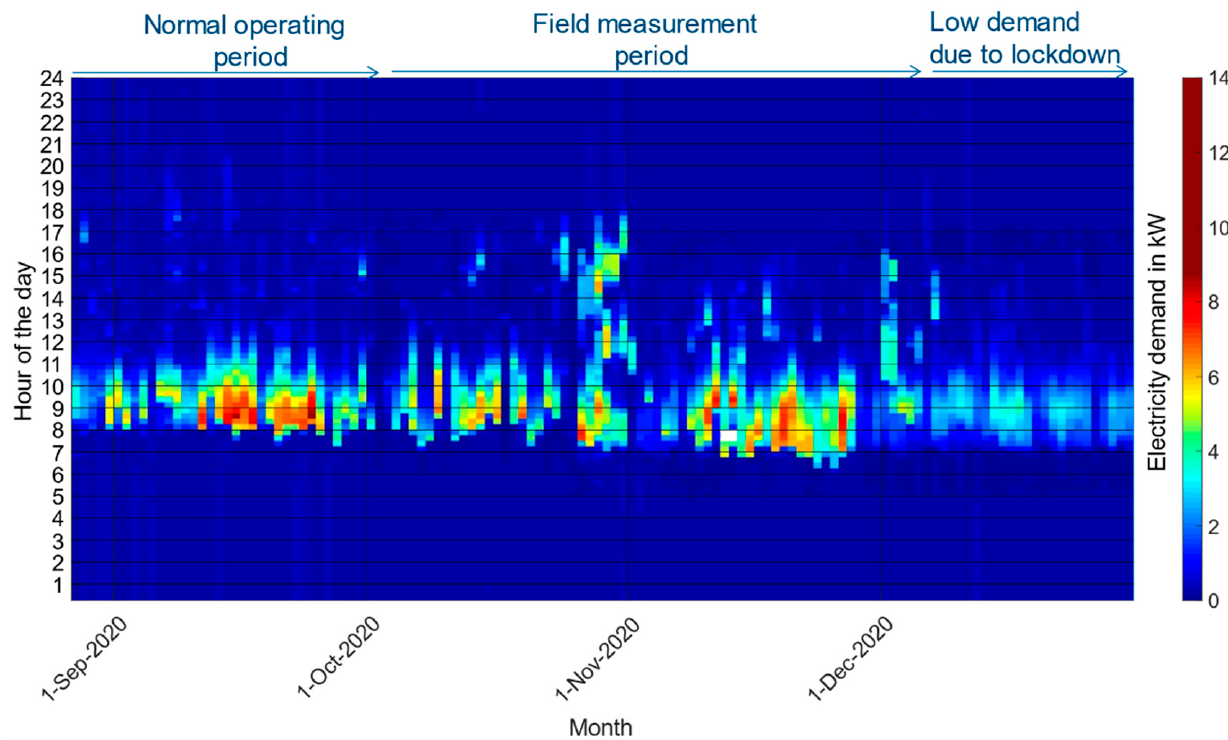
Figure 6 . Carpet plot of measured electricity consumption data from Mbita WeTu Hub . Figure 6. Carpet plot of measured electricity consumption data from Mbita WeTu Hub